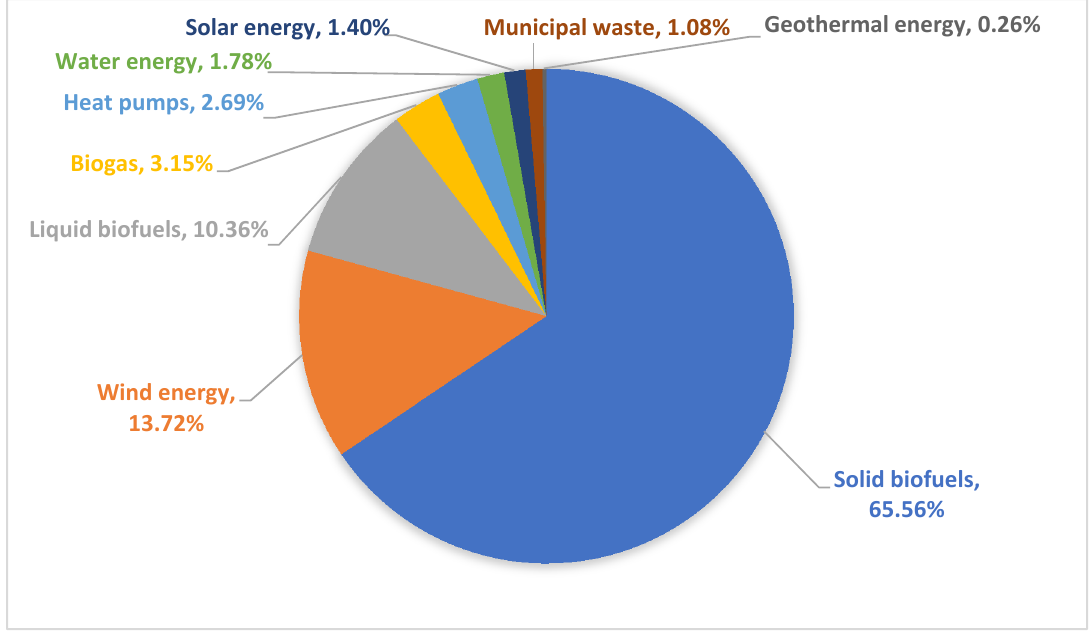
Figure 2. The structure of obtaining energy from renewable sources in Poland in 2019 [27].